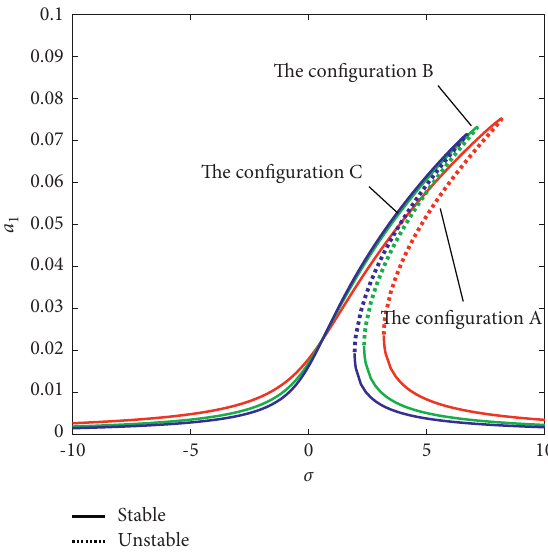
Figure 25: The frequency response curve with different ply se- quences ( c � 0.05, L/d � 10, case I).